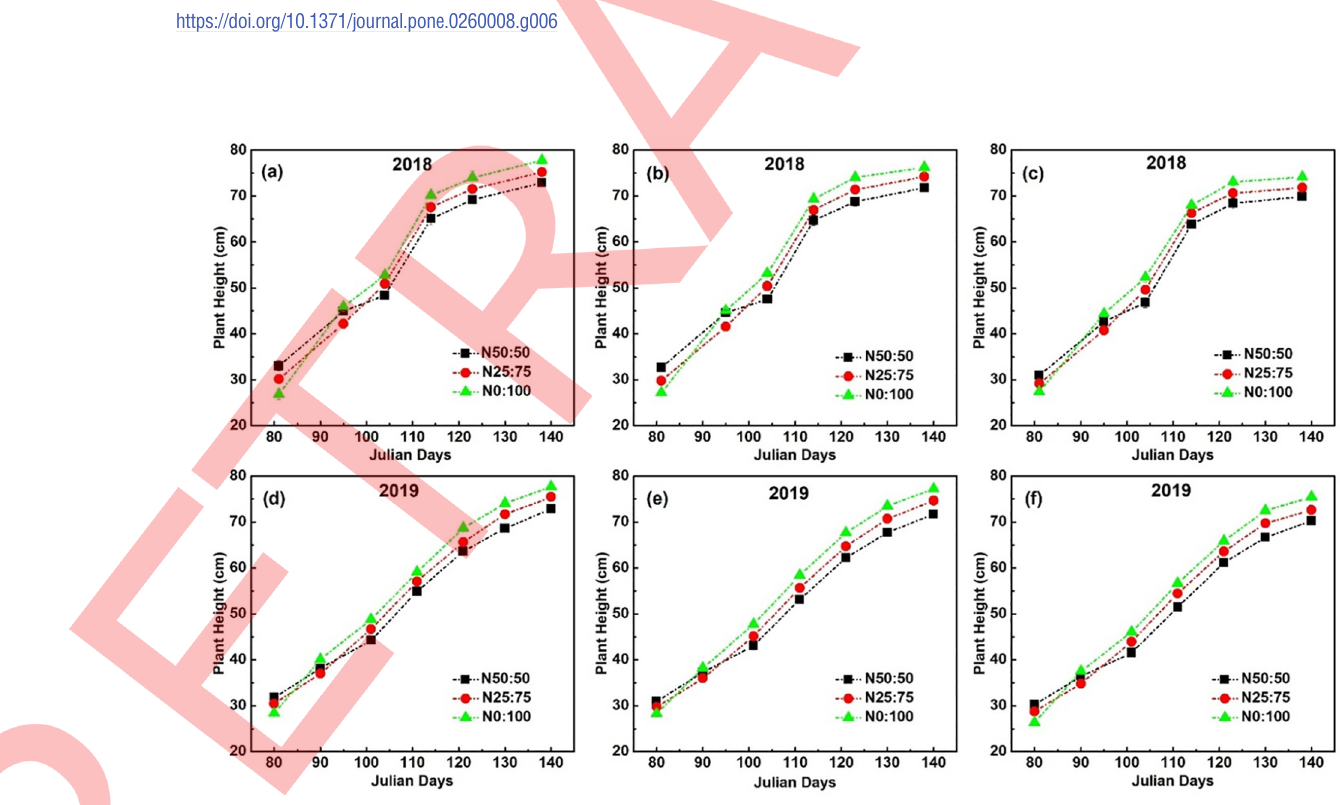
Fig 7. Plant height of winter wheat in (a) D 40 , (b) D 60, and (c) D 80 during the 2017–2018 and 2018–2019 growing season.